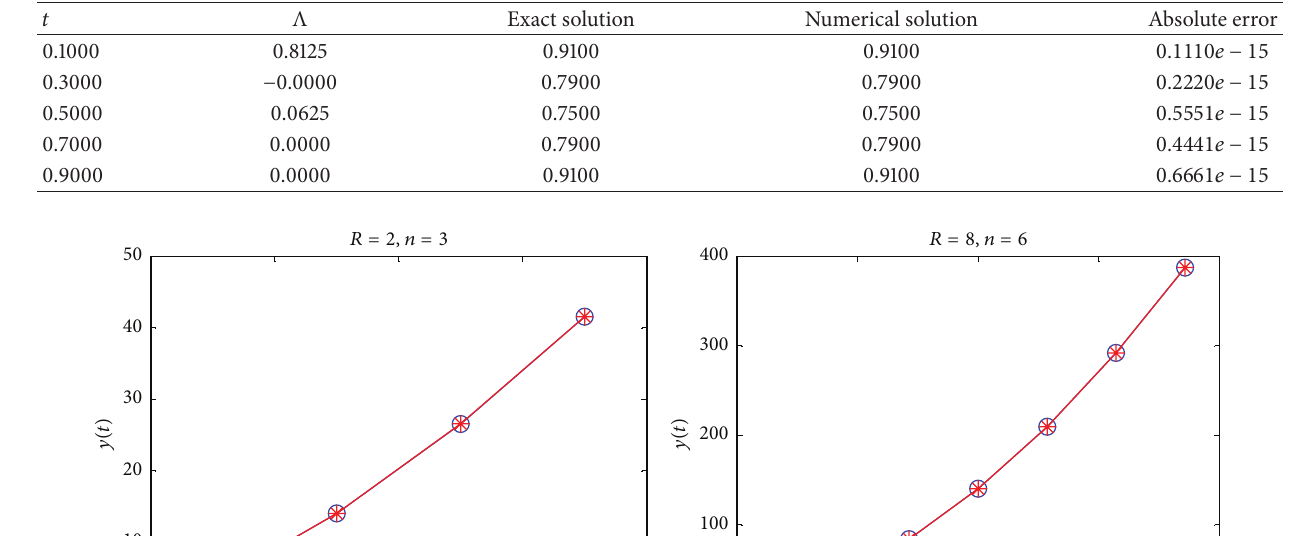
Table 5: Computational results of Example 2 for 𝑅 = 1 and 𝑛 = 4 .